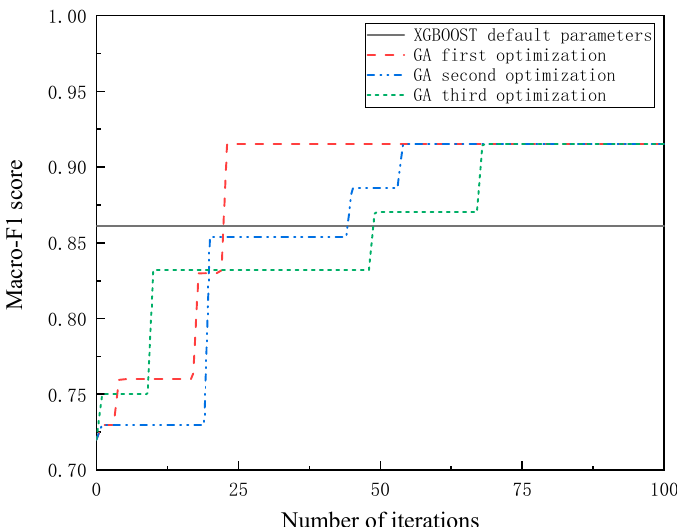
Figure 8. Iteration diagram of genetic algorithm.